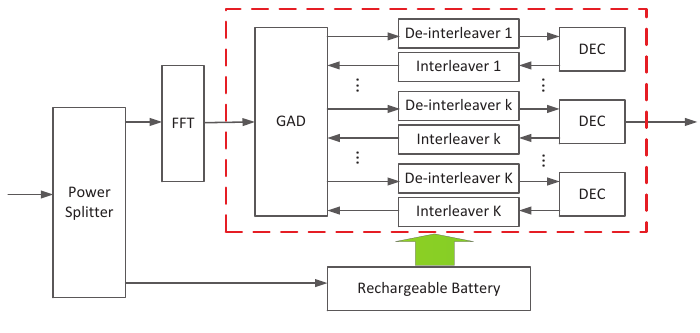
Figure 1. The receiver structure of the k -th